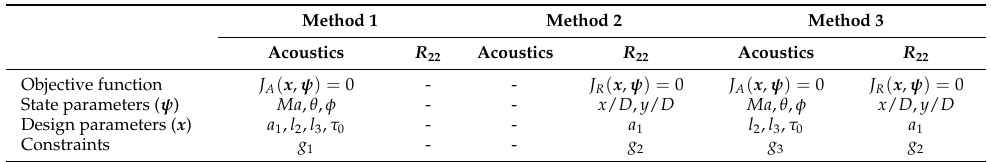
Table 1. Optimization problem statement for each method (hyphens indicate that no optimization was carried out).